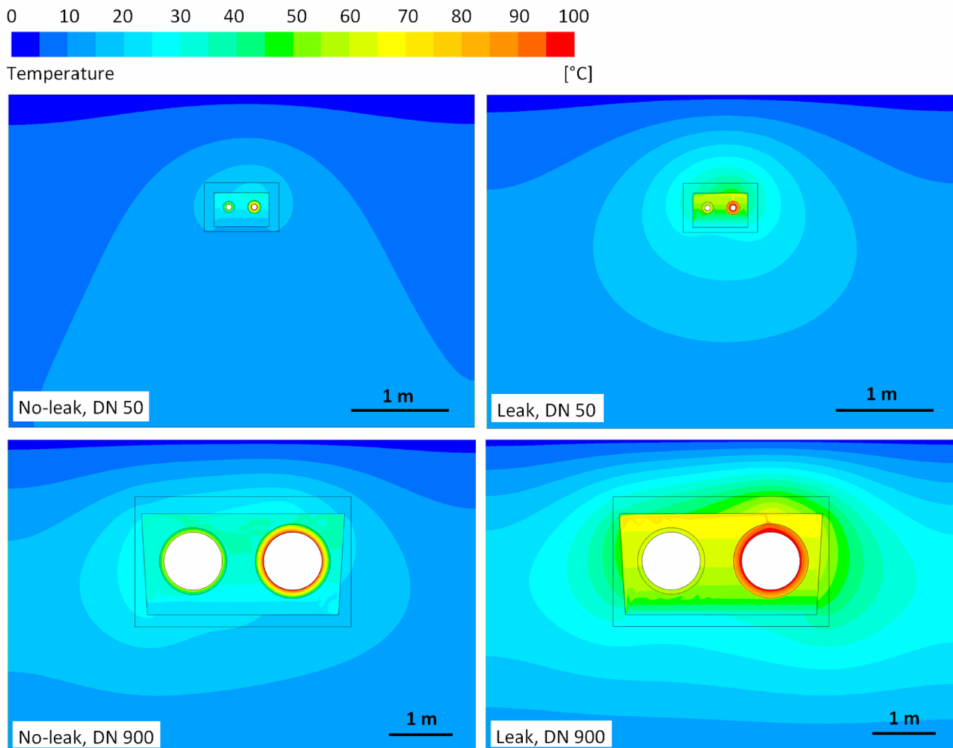
Figure 7. Simulated temperature fields for channels with nominal pipe diameters DN 50 and DN 900; no-leak and leak cases.